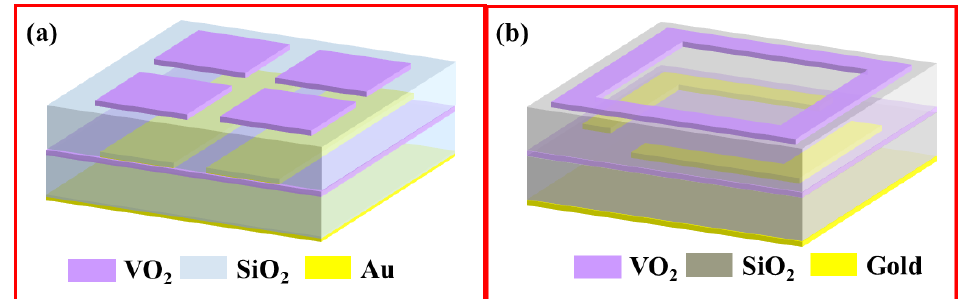
Figure 13. VO 2 -based metamaterial structures realizing absorption and polarization. ( a ) Proposed by Z. Y. Song et al. [152]. ( b ) Proposed by our group [153].